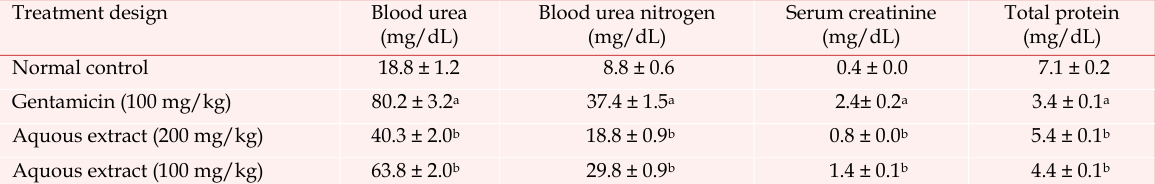
Effect of aqueous extract of leaves of Sechium edule on biochemical parameters in gentamicin-induced ne- phrotoxicity in